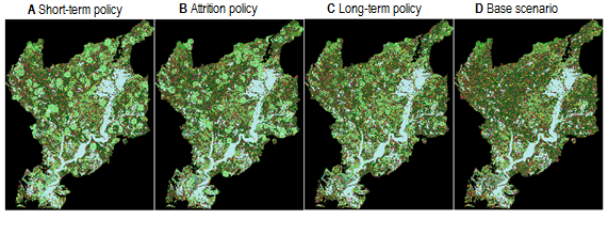
Fig. 5 . Illustration of the area under different management scenarios, 100